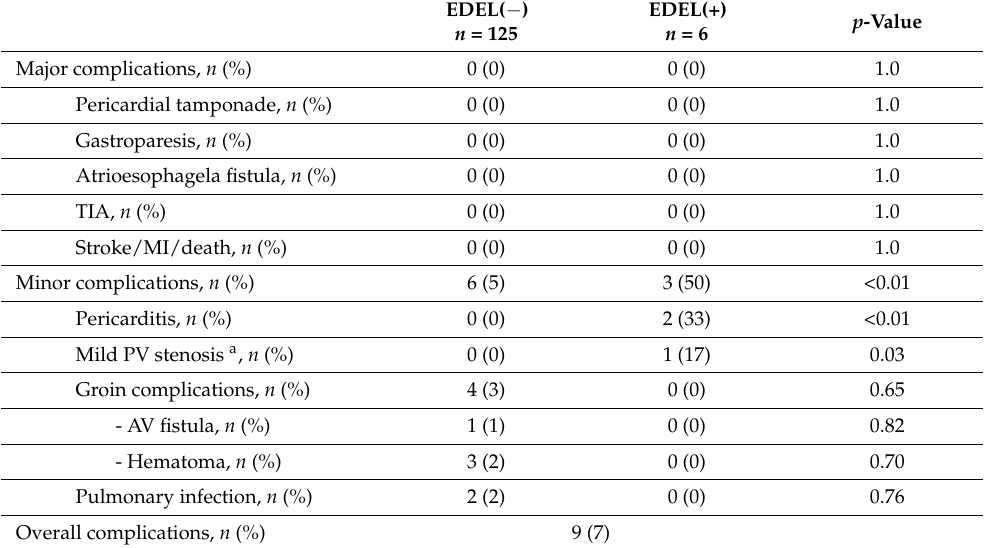
Table 4. Adverse event